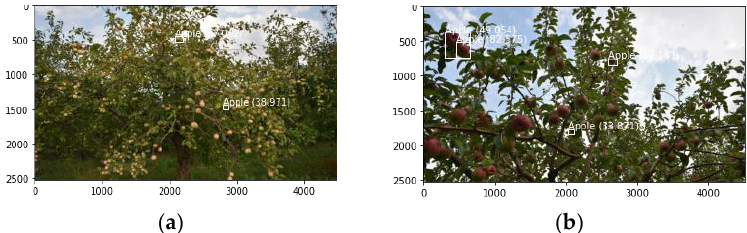
Figure 9. Two ( a ) and 4 ( b ) apples detected in the far-view canopy images without pre-processing.